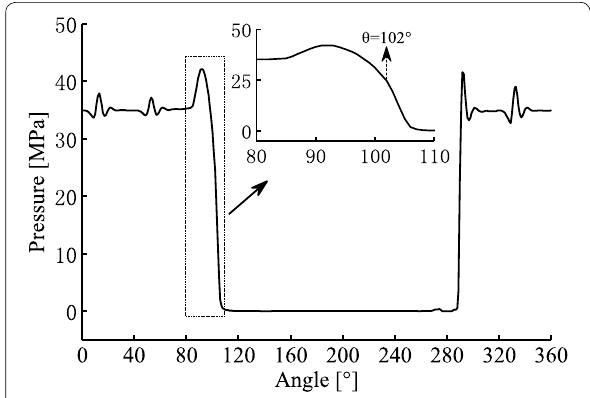
Figure 6 Pressure change in the piston chamber